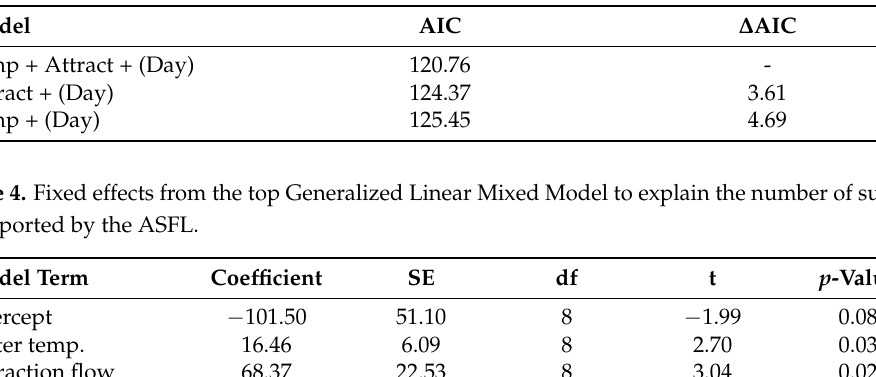
Table 3. List of model and AIC scores for Generalized Linear Mixed Model of suckers lifted by the ASFL. Model variables with fixed effects include average water temperature (Temp ◦ C) and attraction flow treatment (Attract), while day was modelled as a random effect.